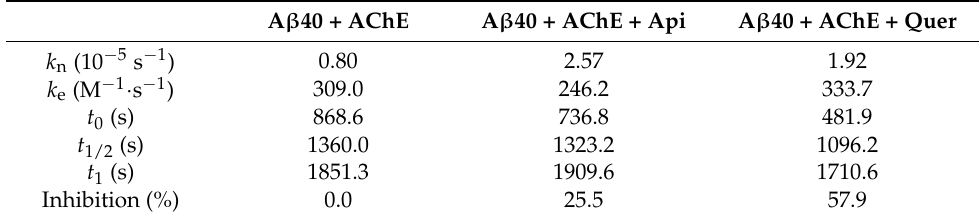
Figure 4. Effect of quercetin and apigenin on the AChE-induced fibrillation of A β 40. The samples were incubated at 37 °C for 24 h and ThT fluorescence emission spectra were recorded in the range 465–600 nm. Green spectrum: typical aggregation of A β ; black dotted spectrum: A β monomers in- cubated at 4 °C (negative control); red spectrum: aggregation in the presence of quercetin; blue spec- trum: aggregation in the presence of apigenin. Conditions: [Quercetin/Apigenin] = 20 μ M; [A β 40] = 20 μ M; [AChE] = 4 μ M. The assays were performed in triplicates, and SD values <5% were obtained in all cases (not shown for the sake of clarity). Table 2. Kinetic parameters obtained for the AChE-induced aggregation of free A β 40, A β 40 with apigenin and A β 40 with quercetin.